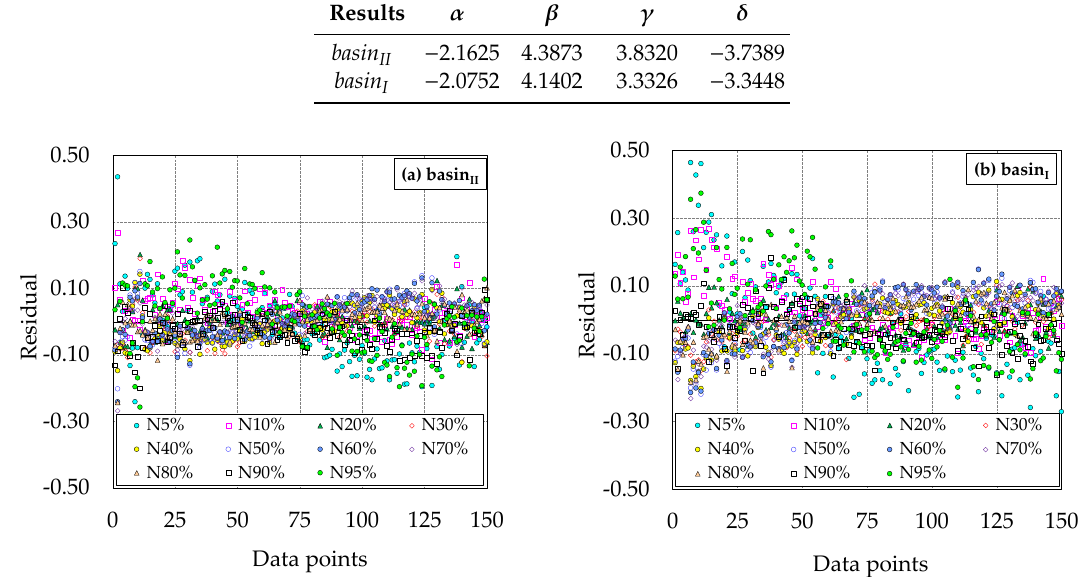
Figure 9. Residual plots of the experimental and estimated data set of the N K% coefficient for different probabilities: ( a ) basin II and ( b ) basin I .